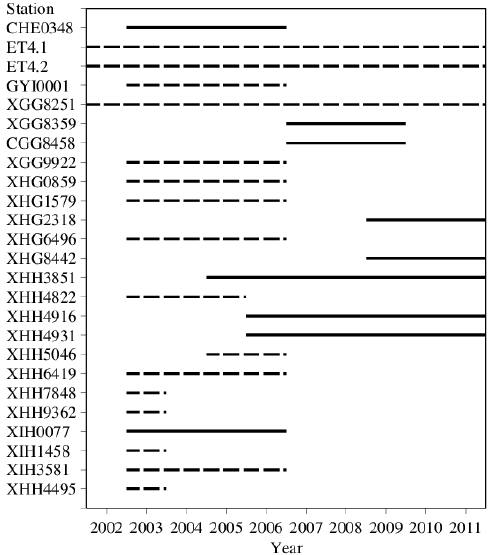
Figure 2. Monitoring stations and data availability. Dashed lines indicate cruise ‐ based biweekly and monthly data and continuous lines indicate Continuous Monitoring (CMON) data collected with electronic sensors at a 15 min interval. electronic sensors at a 15 min